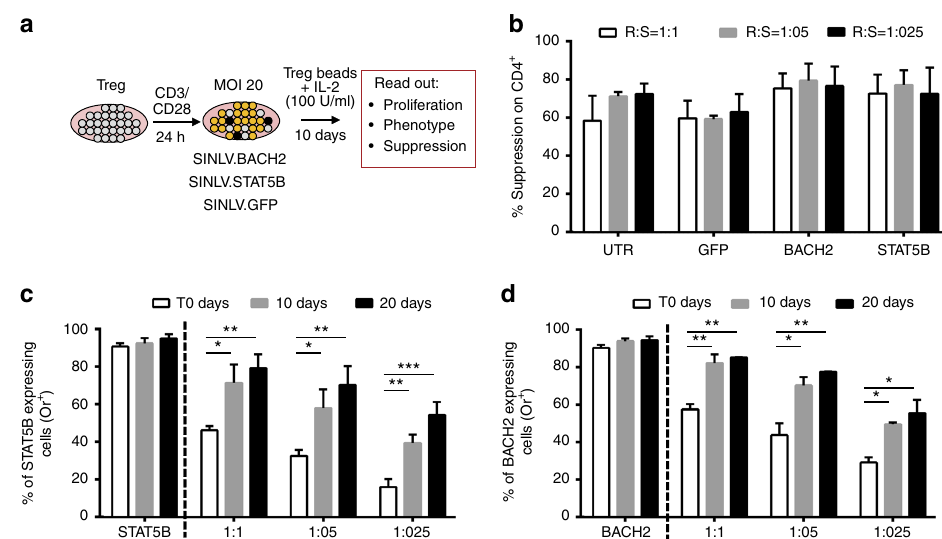
Fig. 6 Effects of the forced expression of STAT5B and BACH2 in Treg cells. a Experimental strategy. Treg cells were puri fi ed from PBMC of HDs, were activated by anti-CD3/CD28 Treg expander beads for 24 h, transduced with the indicated LVs, and cultured for 10 days in presence of Treg expander beads and IL-2 (100 U/ml). b Inhibition of proliferation (analyzed by fl ow cytometry for e-Fluor dilution and indicated as % Suppression vs. responder alone) of anti-CD3/CD28 activated allogeneic Responder (R) cells cultured in presence of different doses (Ratio R:S were 1:1, 1:05, and 1:0.25) of Suppressive cells (S). c , d Percentage of Orange + Treg cells expressing STAT5B ( c ) or BACH2 ( d ) measured over time and cultured alone (indicated as STAT5B and BACH2) or in presence of Treg cells transduced with the control LV ( c ) (Ratio GFP-expressing and STAT5B-expressing cells is 1:1, 1:05, and 1:025, the same for GFP-expressing and BACH2-expressing cells). Signi fi cance was determined by performing two-way ANOVA with Bonferroni correction on Log ODD transformed % values (* p < 0.05; ** p < 0.01). Data are represented as Mean ± SEM, and for all panels N =